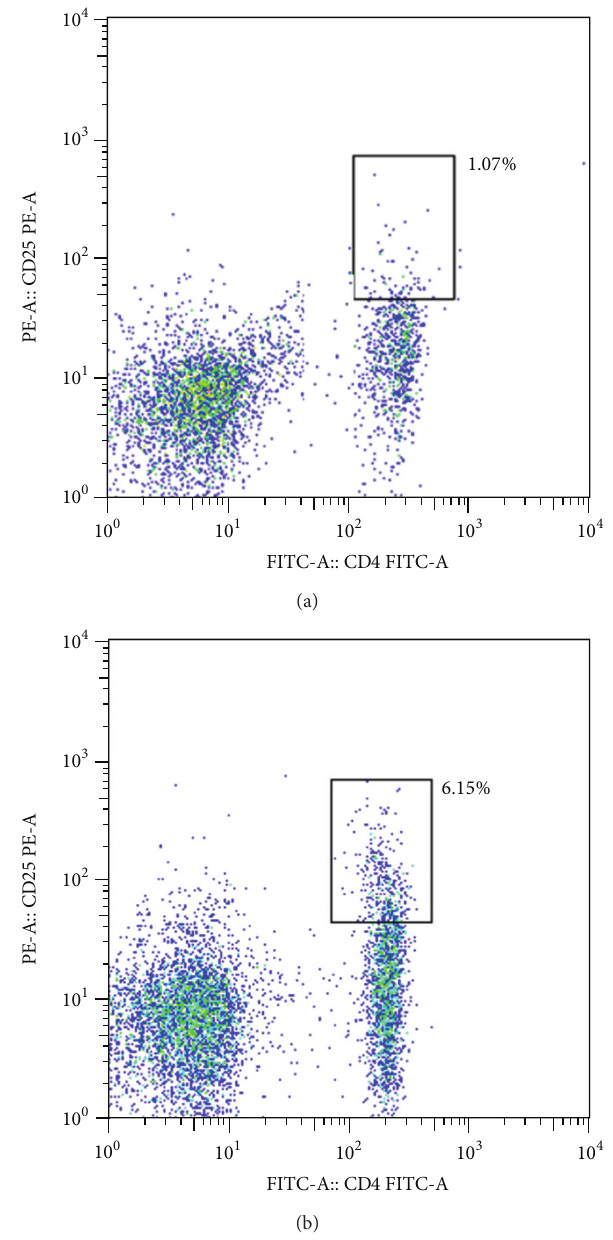
Figure 4: Rats treated with AX059 (b) displayed an increase in the percentage of Tregs during EAE induction compared with those treated with vehicle (a).